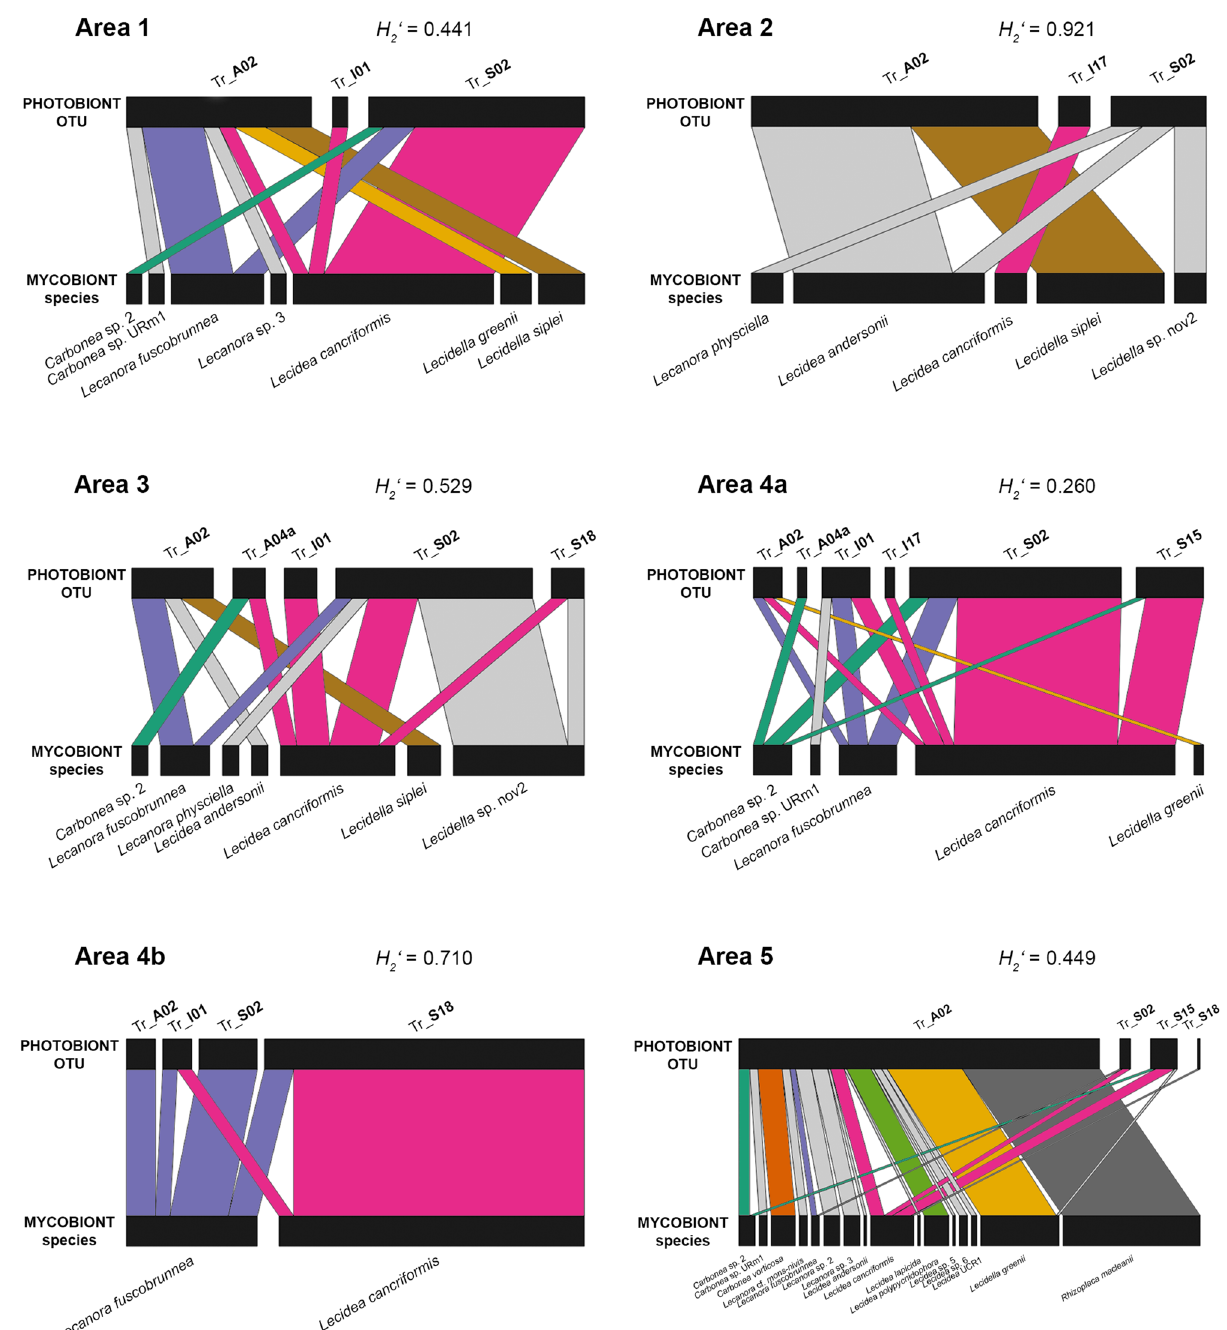
Figure 6. Bipartite networks showing the associations between mycobiont species and photobiont OTUs for the different areas. Rectangles represent species/OTUs, and the width is proportional to the number of samples. Associated species/OTUs are linked by lines whose width is proportional to the number of